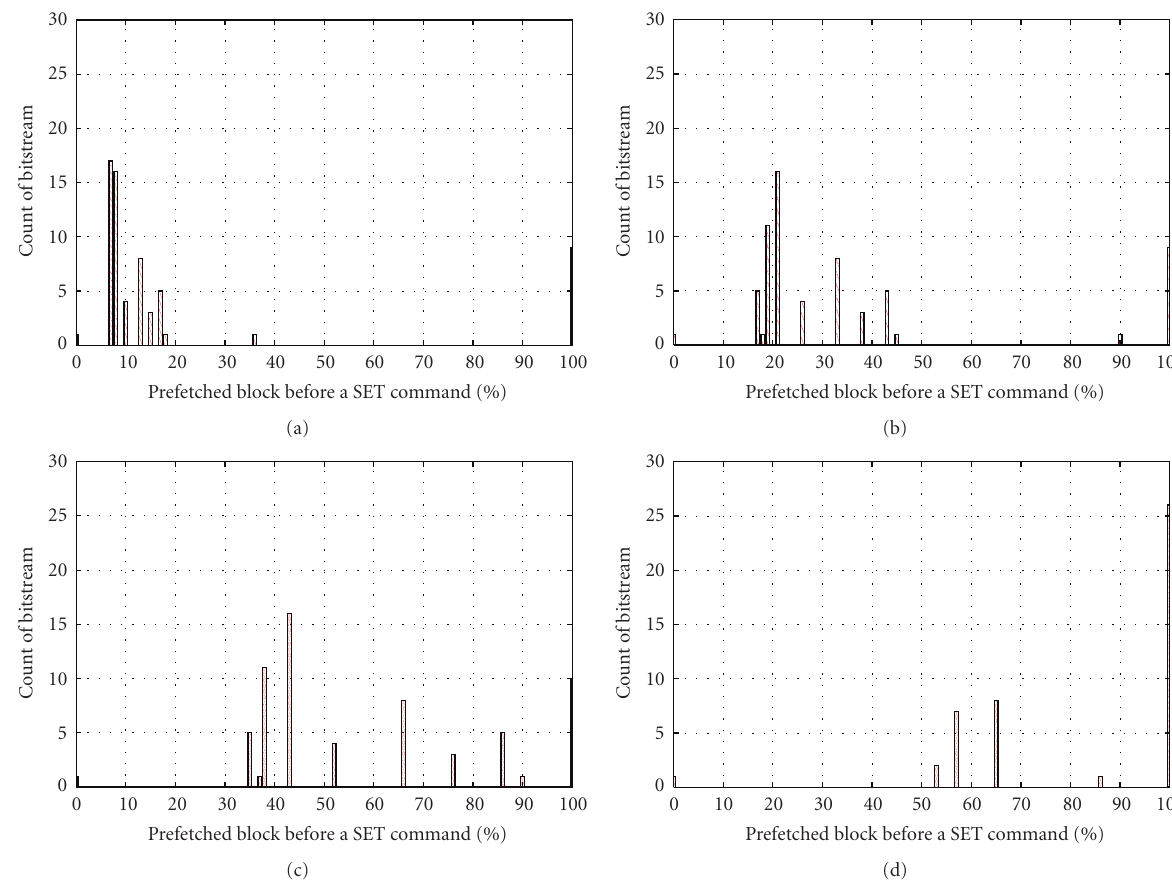
Figure 8: Histograms showing the prefetch results; from top (a) to bottom (d), the execution time is 1, 2.5, 5, and 7.5 milliseconds.